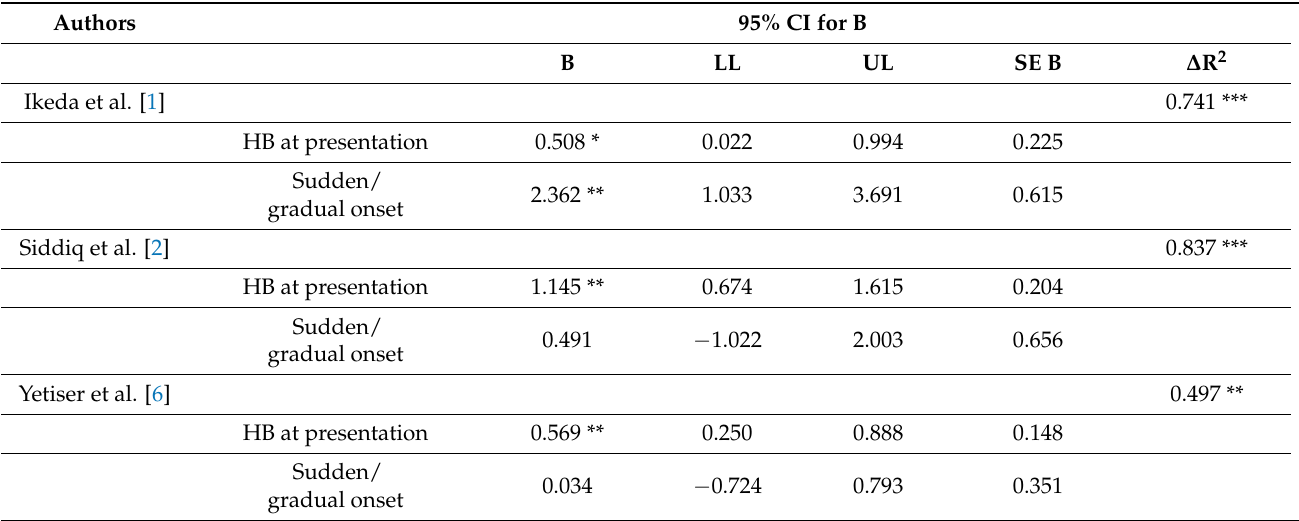
Table 6. Multiple regression analysis to predict facial recovery (postoperative HB grade) from sudden/gradual onset of facial palsy and HB grade at presentation. B: unstandardized regression coefficient, CI: confidence interval, LL: lower limit, UL: upper limit, SE B: standard error of